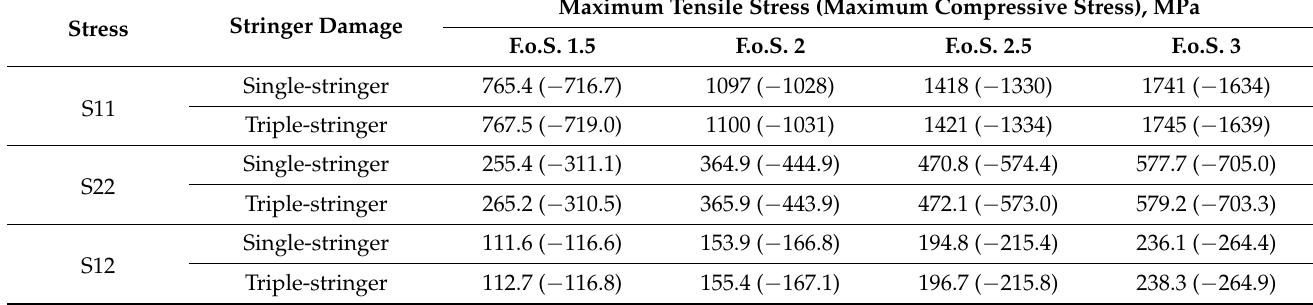
Table 12. Maximum values of stress components in the wing models containing stringer damage.